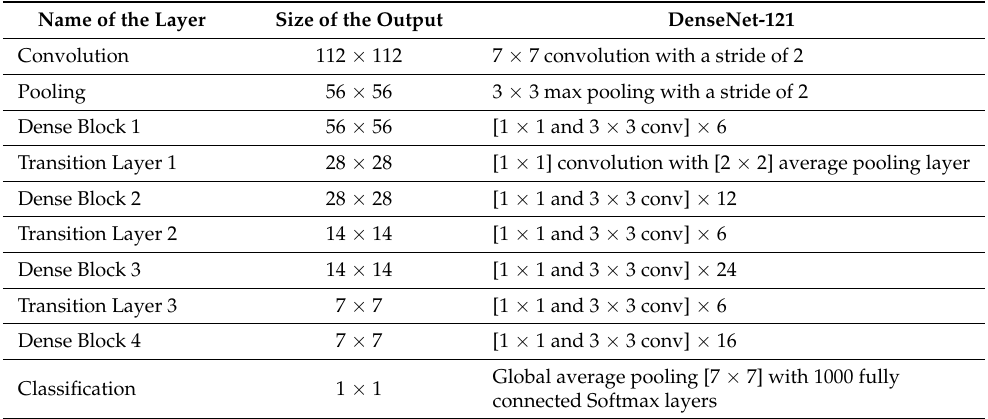
Table 3. Layers in DenseNet121